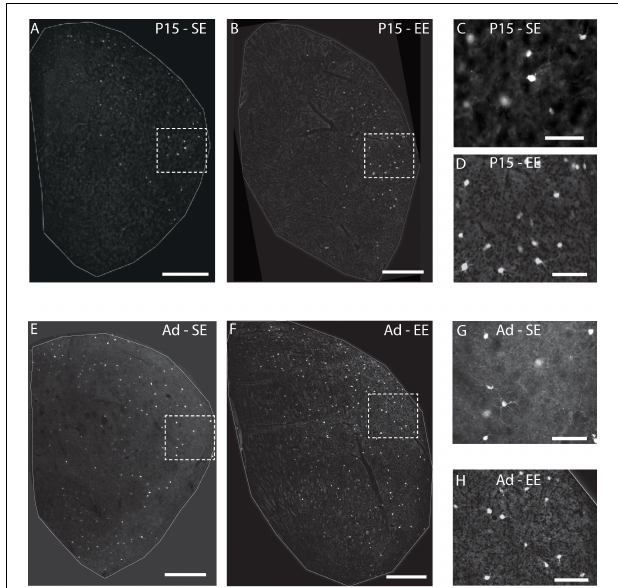
FIGURE 1 | Environmental enrichment affects the emergence of striatal PV expression. Sample striatal sections showing the pattern of PV immunostaining (bright label) at P15 and adult samples of standard (SE) housed mice ( A,E respectively). PV staining at approximately 2 weeks is most prominent in the lateral part of the striatum, spreading medially with age. Comparable sections depicting sample striatum of P15 and adult enriched (EE) mice ( B,F respectively). Note the greater density of positively stained PV cells at both ages assessed compared to standard-housed controls at the same age. The rightmost, smaller, vertical pairs of panels depict higher power images of PV labelling from the white dotted line boxes in P15 ( C,D for boxes in A,B respectively) and adult ( G,H for E,F respectively) samples of the same row. Scale bars (in images): 350 µ m in (A,B,E,F) ; 100 µ m for (C,D,G,H)